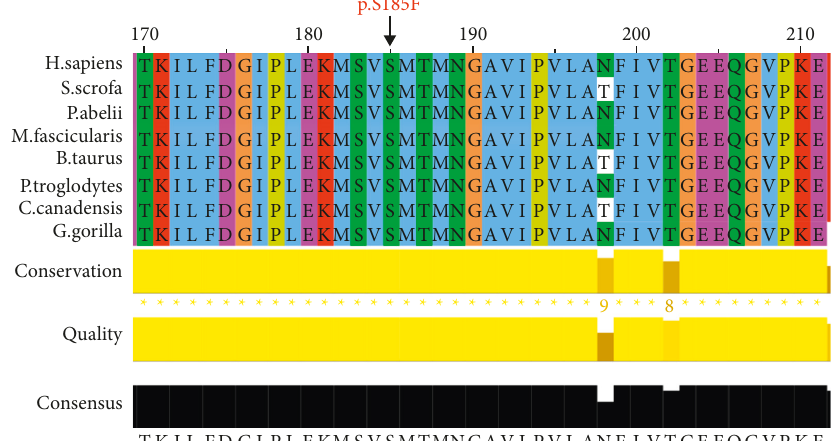
Figure 2: The conservation of MMUT variants. Multiple sequence alignment of the MCM protein for different species (black arrow denotes the position of the variant) (c.554C > T